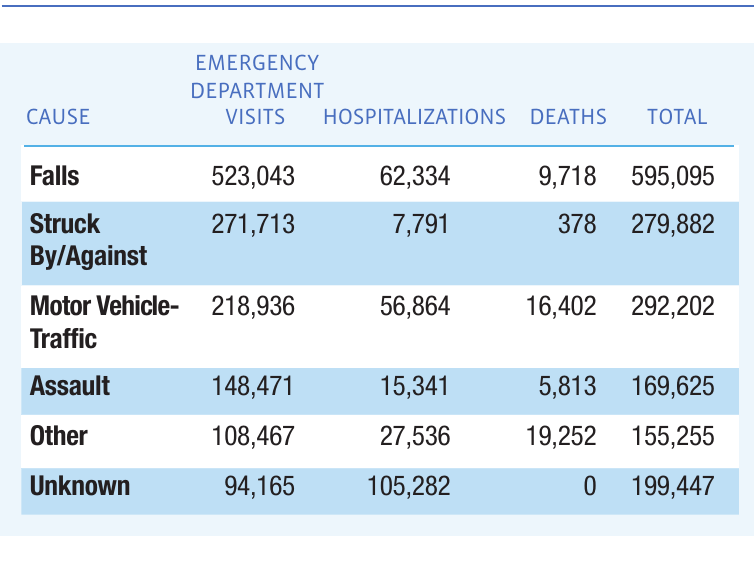
TABLE D: Estimated Average Annual Numbers of Traumatic Brain Injury-Related Emergency Department Visits, Hospitalizations, and Deaths, by External Cause, United States, 2002–2006